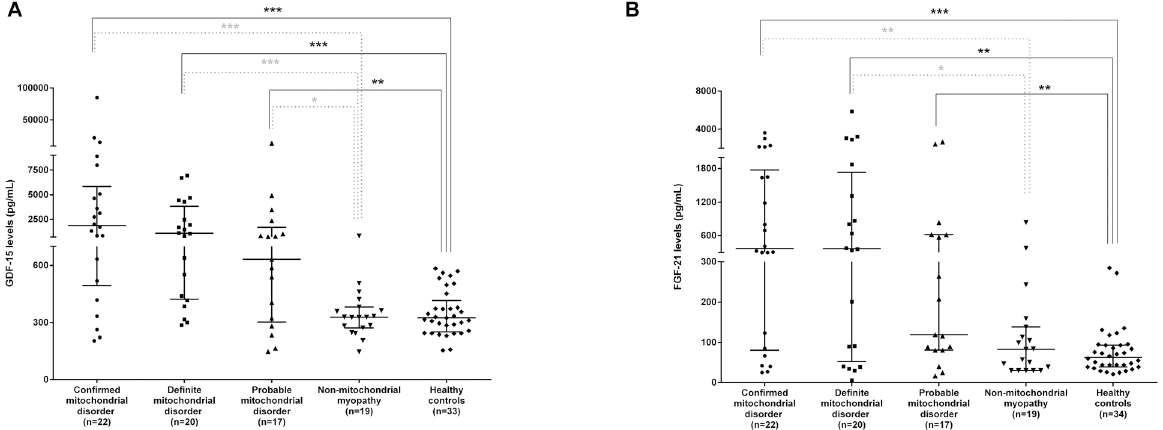
Fig 1. GDF-15 and FGF-21 circulating concentrations. Data are represented as the median +/- the interquartile range. * p < 0.05, ** p < 0.01, *** p < 0.001 (U-Mann-Whitney test).